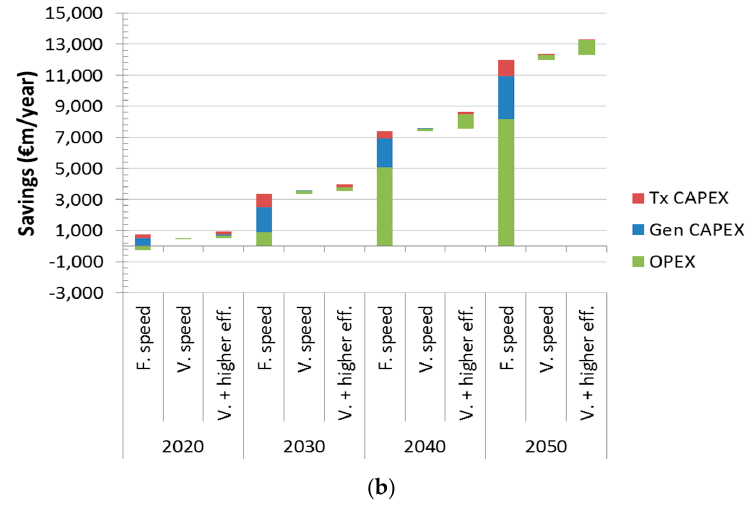
Figure 5. Values of PSP technologies. ( a ) Low renewable energy resources (RES) scenario; ( b ) High renewable energy resources (RES) scenario.